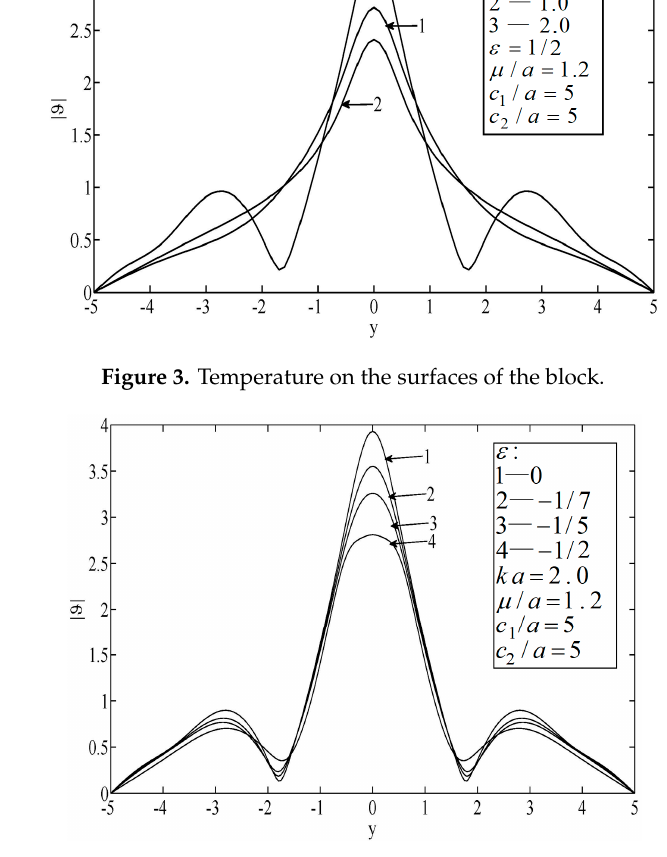
Figure 4. Temperature on the surfaces of the block.